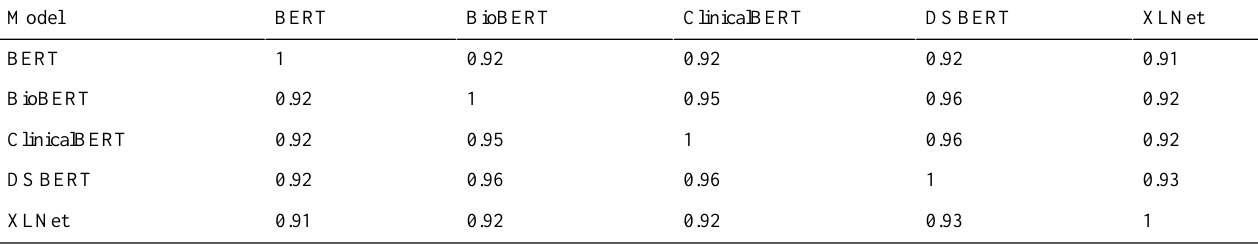
Table 2. Correlation between the predictions of each transformer model on the test set.